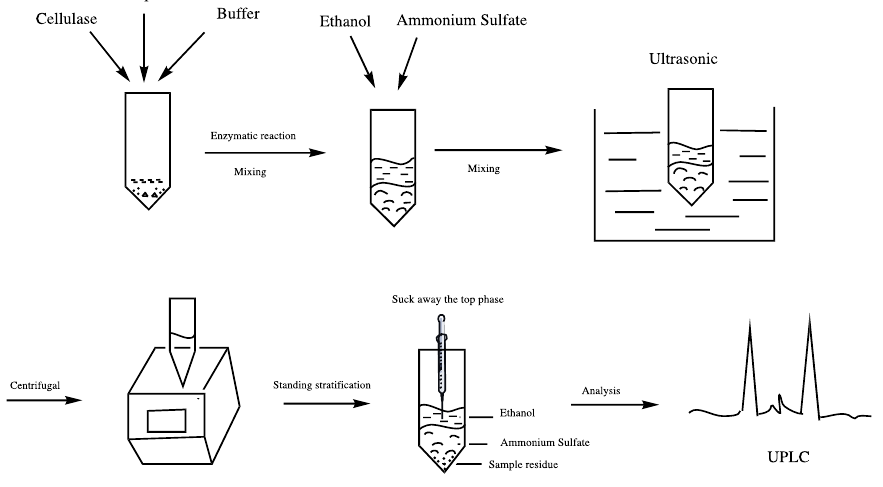
Figure 1. Diagram of